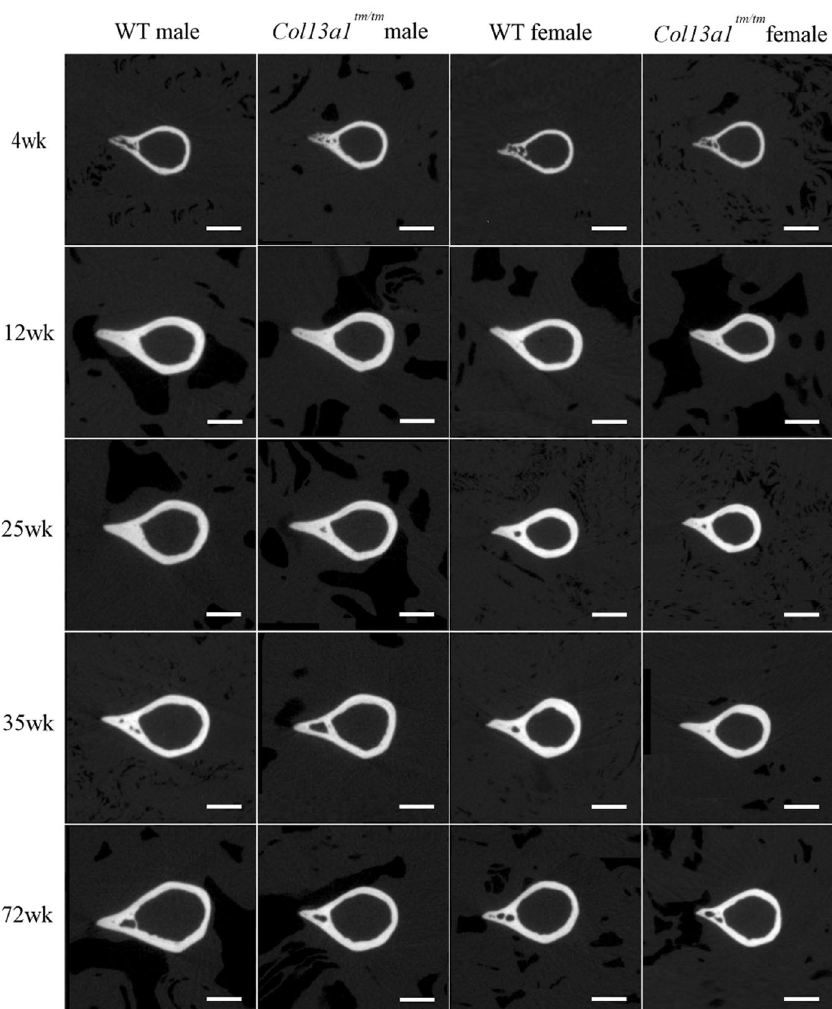
Figure 2. Single-scaled mid-diaphyseal axial tomographic µCT images of male and female Col13a1 tm/tm mouse femurs and respective controls. From the 4- to 35-week time points, diaphyseal cortical bone morphology remained mostly unaltered in the Col13a1 tm/tm samples compared to the controls, whereas at 72 weeks a slight reduction in bone mass could be seen compared to the WT samples. Scale bars 1